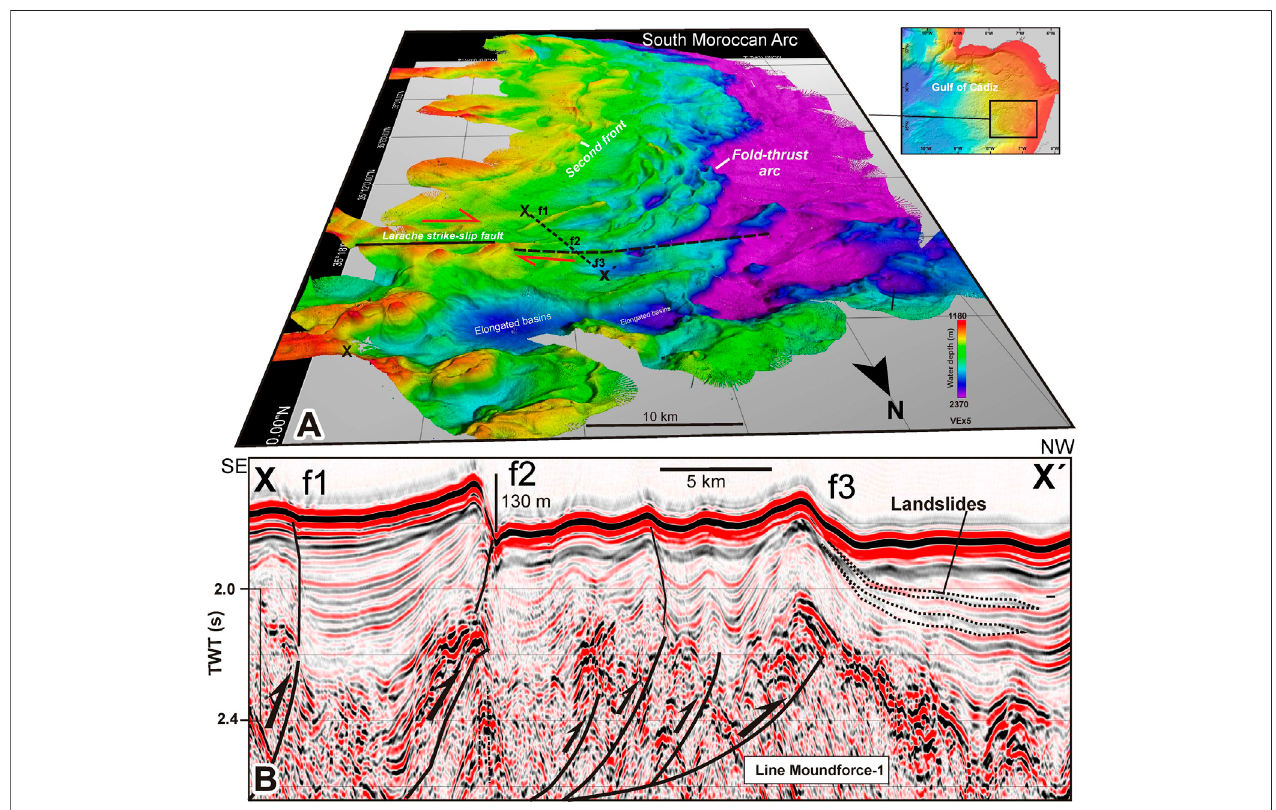
FIGURE 5 | (A) 50 × 60 km 3 days image of the multibeam bathymetry of the South Moroccan Arc -SMA [data from Somoza (2007), Somoza et al.(2008)]. f1 to f3 are splays of the Larache right-lateral strike-slip fault. (B) Multichannel seismic pro fi le MOUNDFORCE-01 crossing the SMA. The Larache strike-slip fault is split to the west into several fold-thrusts systems (f1 to f3) which deform the seabed in the South Moroccan Arc (Inset location in Figure 2 ).